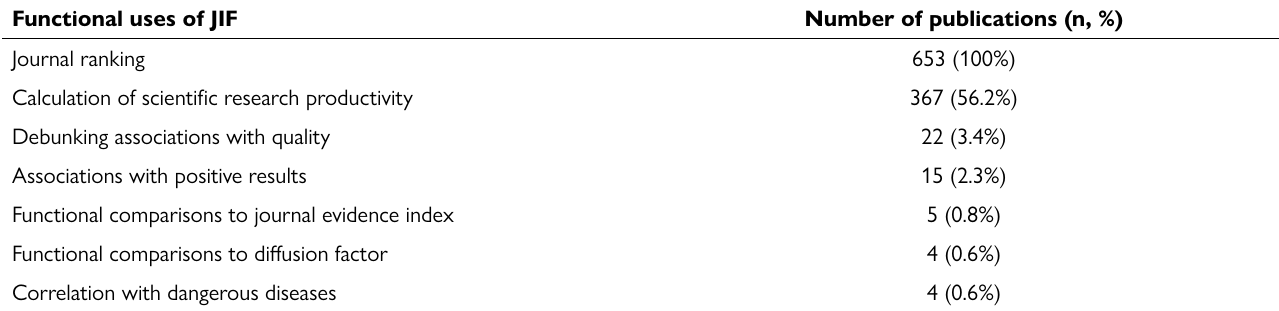
Table 3. Percentage of sample displaying specific functional uses of JIF (n = 653). Functional uses of